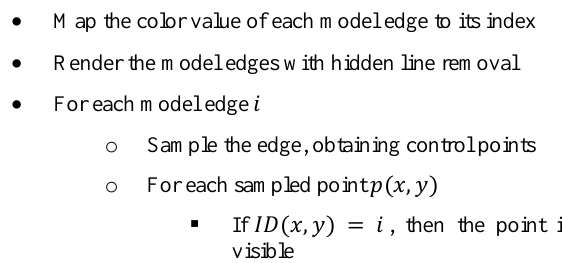
Figure 6. Sampled points distance (x, y) in edges varies to maintain number of points proportional to edges size (size, SIZE). 2) Visible edges detection: Self-occlusion, which occurs